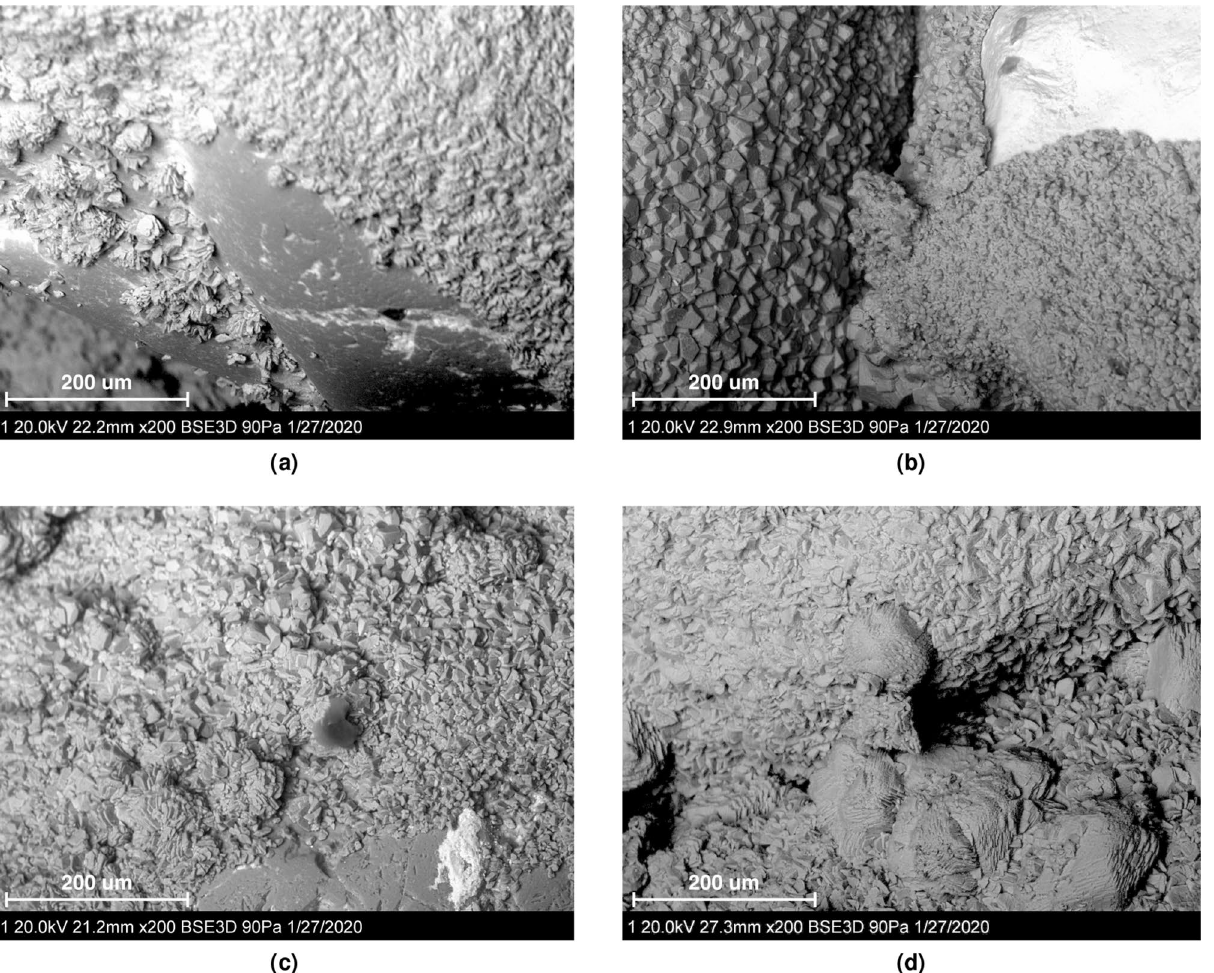
Figure 7. SEM imaging of the specimen generated with ( a ) the highest urease activity (237.4 mmol/L/h) at OD 600 = 2, ( b ) the highest urease activity (237.4 mmol/L/h) at OD 600 = 3, ( c ) the lowest urease activity (0.45 mmol/L/h) at OD 600 = 2 and, ( d ) the lowest urease activity (0.45 mmol/L/h) at OD 600 =